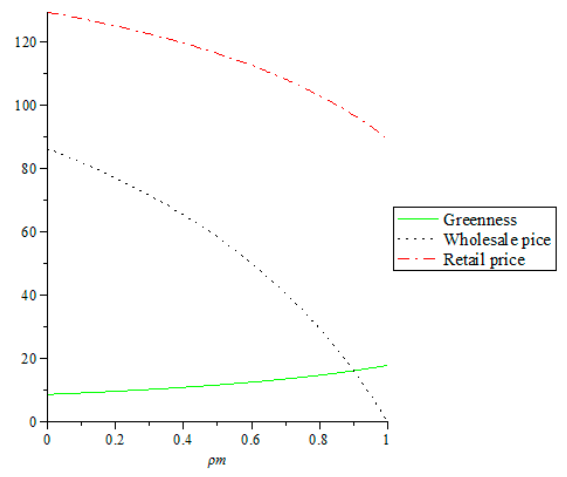
Figure 4. The impact of altruistic preference coefficients of two manufacturers on product greenness, wholesale prices and retail prices.